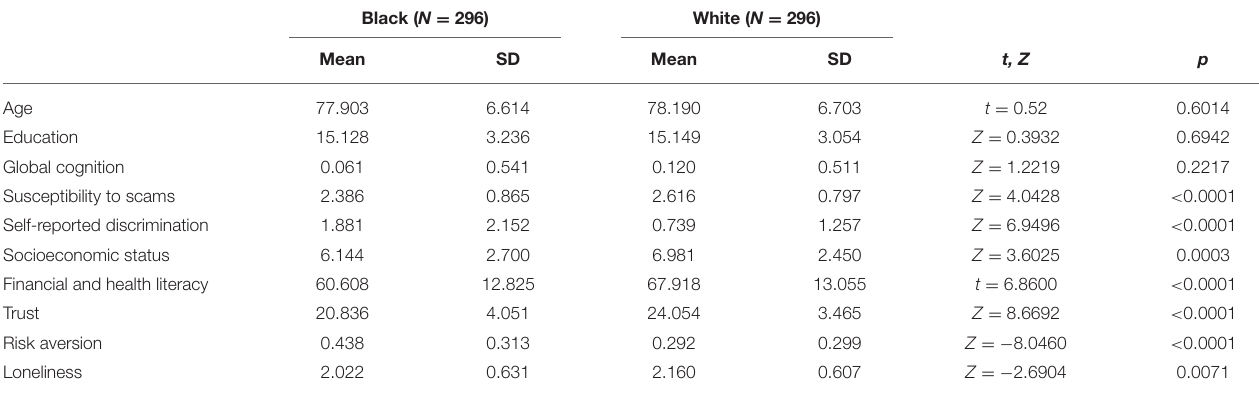
TABLE 1 | Demographic, cognitive, and other descriptive data.